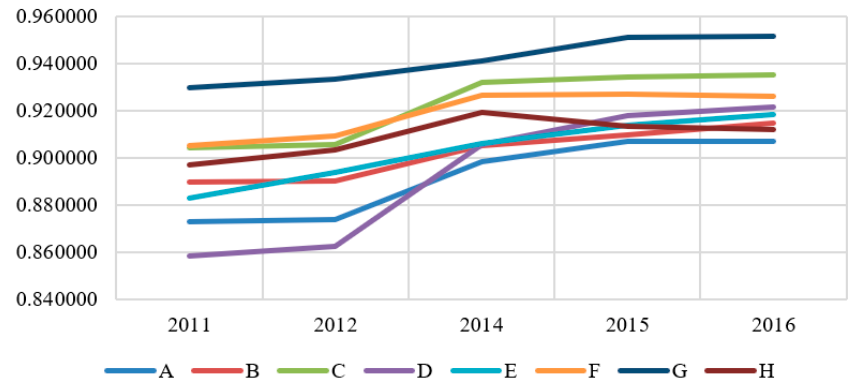
Figure 6. The average value of the using the mileage of the vehicle fleet rate for the analysed road freight transport enterprises in the years 2011–2016.